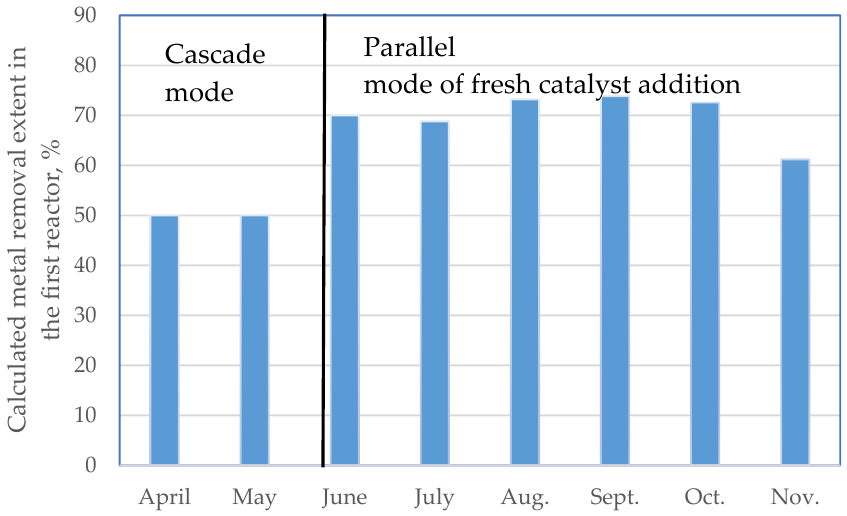
Figure 15. Calculated metal removal extent in the first ebullating bed reactor.